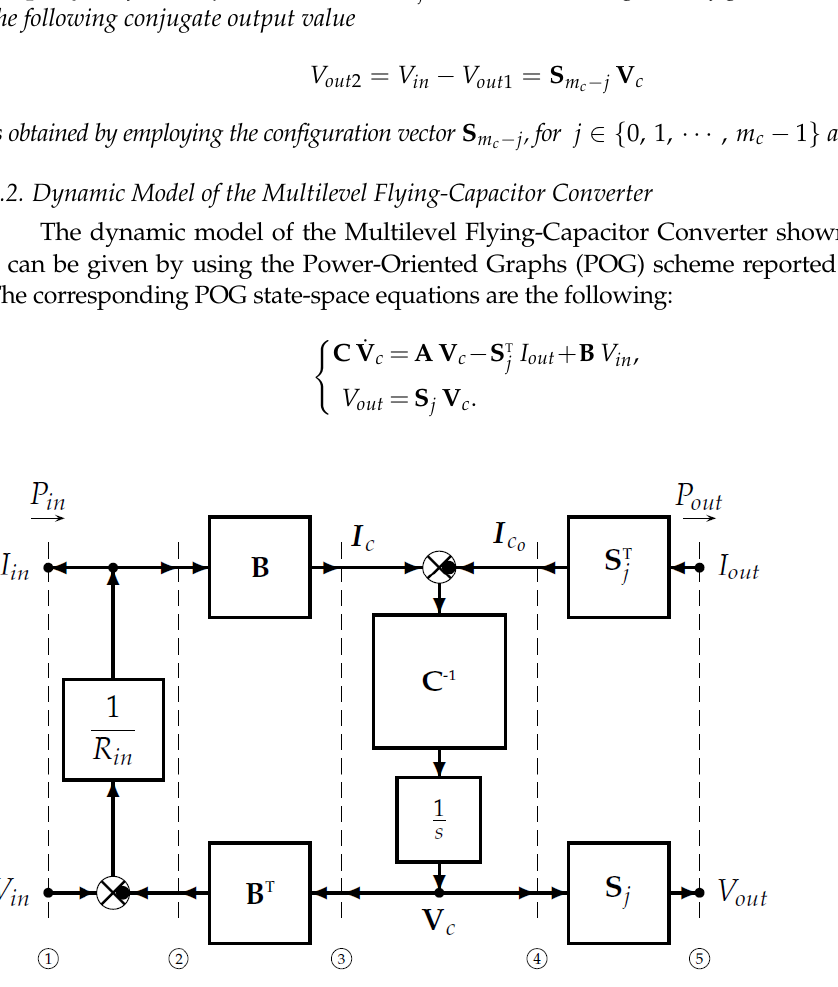
Figure 4. Power-Oriented Graphs (POG) model of the Multilevel Flying-Capacitor